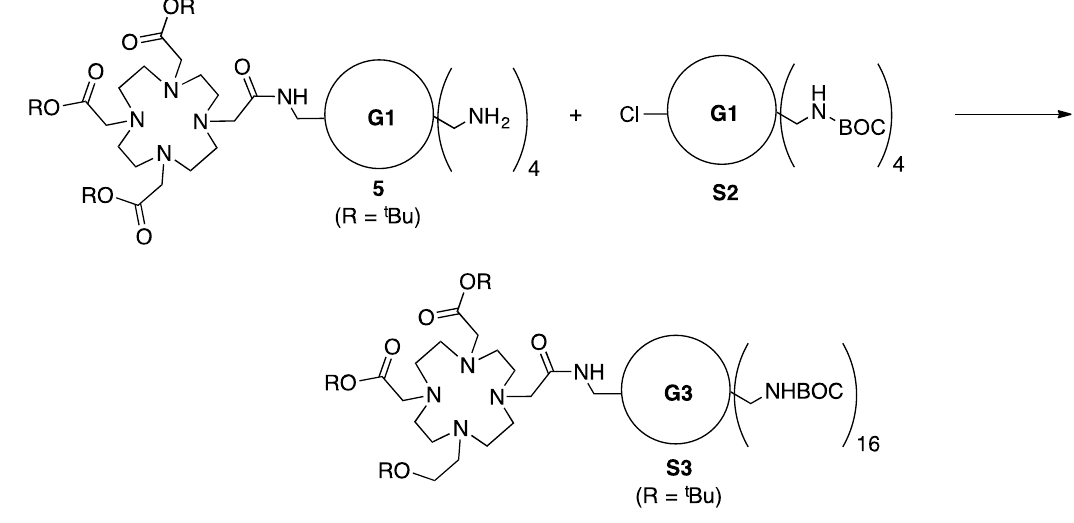
Figure 7. Synthesis of Intermediate S3 . Figure 9. Synthesis of Intermediate S3